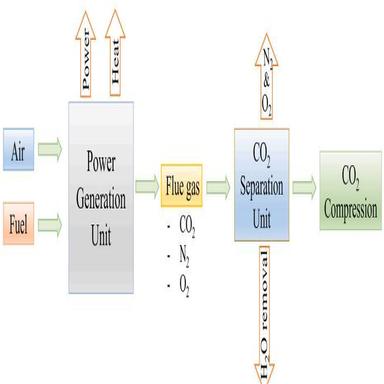
Shows the schematic representation of pre combustion process.